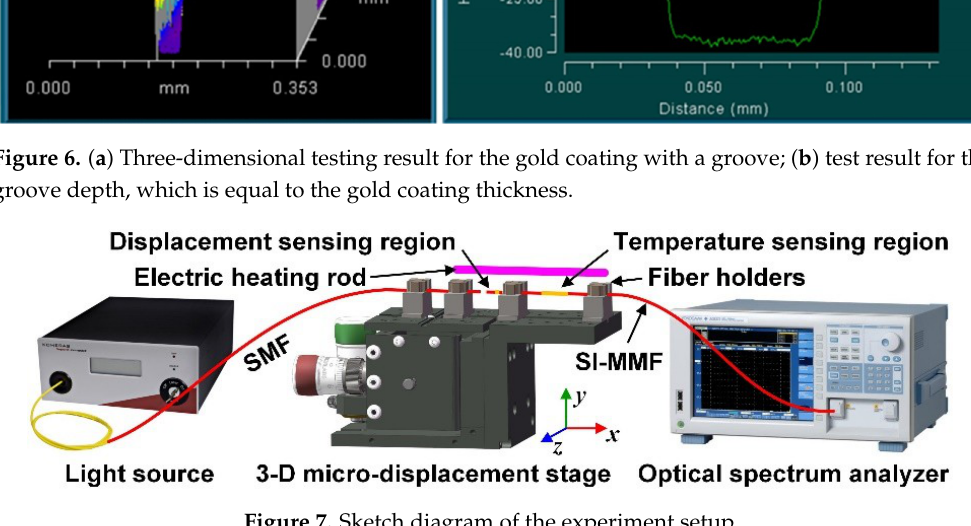
Figure 7. Sketch diagram of the experiment setup.